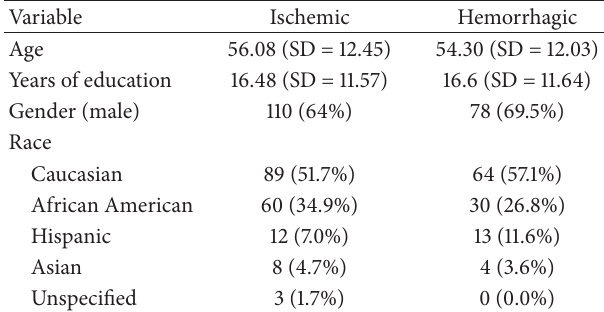
Table 1: Demographic characteristics of